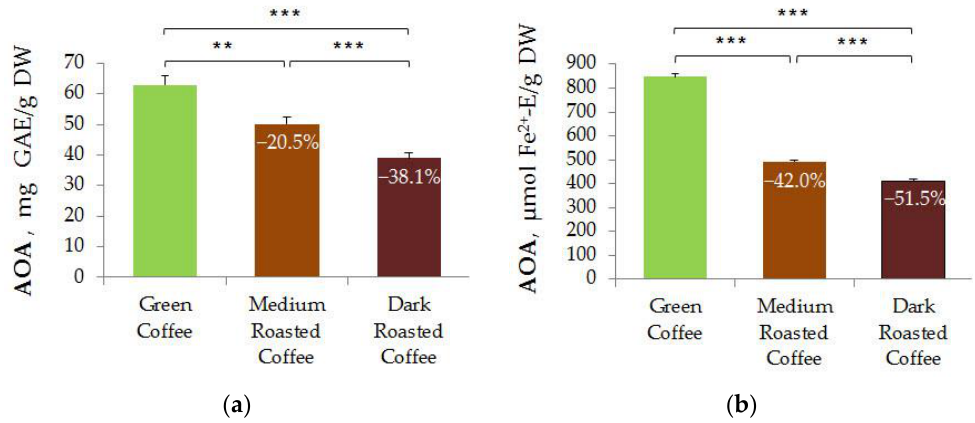
Figure 2. The AOA of aqueous extracts of untreated coffee beans measured by spectrophotometric ( a ) and potentiometric ( b ) methods ( n = 3). Percentage indicates the change in mean AOA after roasting relative to green coffee. Bars indicate the upper boundaries of the SD. Statistically significant differences are indicated by two ( p < 0.01) and three ( p < 0.001) asterisks.